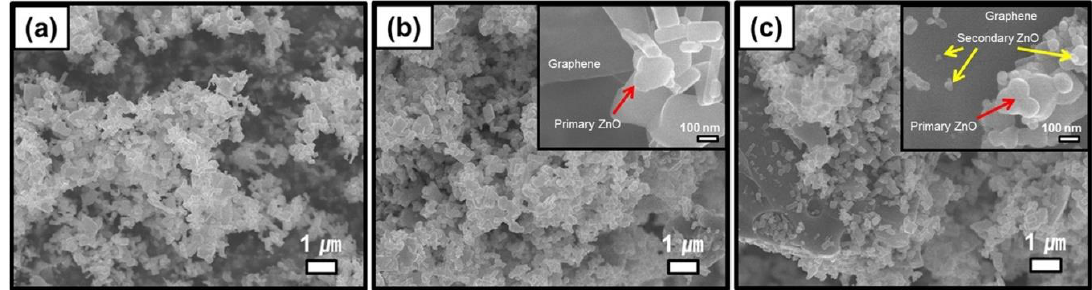
Figure 81. SEM images of ( a ) pristine ZnO NPs, ( b ) ZnO NPs / graphene nanocomposites without the microwave sintering process and ( c ) ZnO NPs / graphene nanocomposites after the microwave sintering process. Products synthesised by the microwave sintering process. Reprinted from [927], Copyright